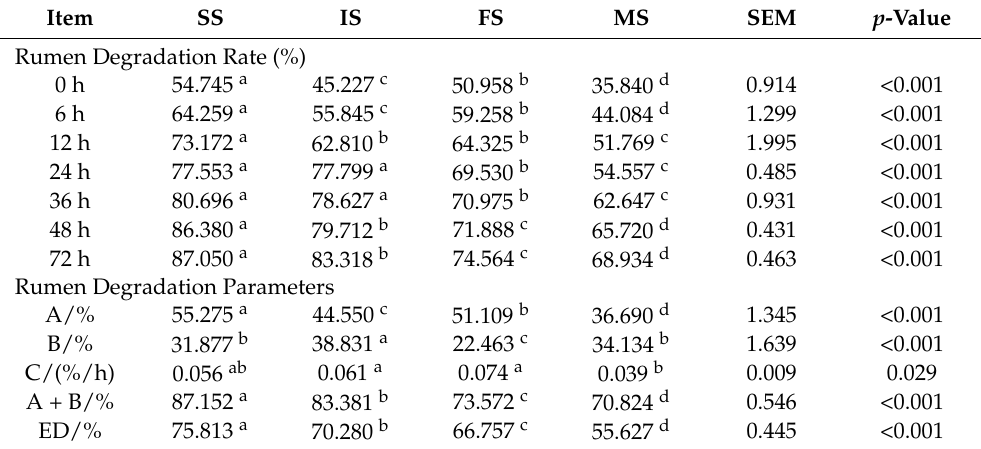
Table 4. Ruminal CP degradation characteristics of Amaranthus hypochondriacus